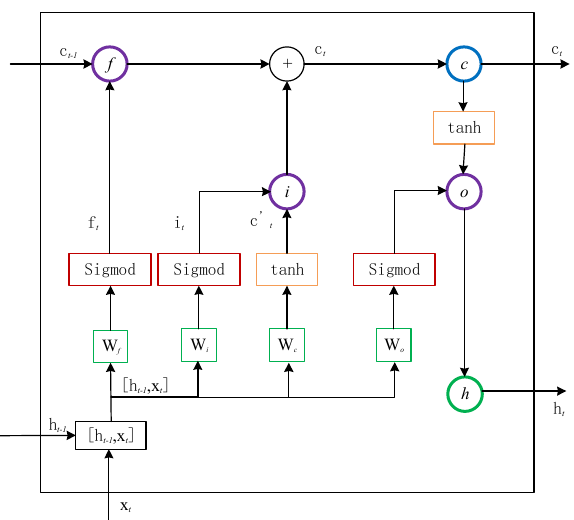
Figure 2. LSTM (Long Short-Term Memory) unit: f is the forgetting gate, i is the input gate, o is the output gate, c is the cell and h is the hidden layer state, b is the bias term, W is the weight matrix. The final output of LSTM is determined by the value of the output gate and the unit state.